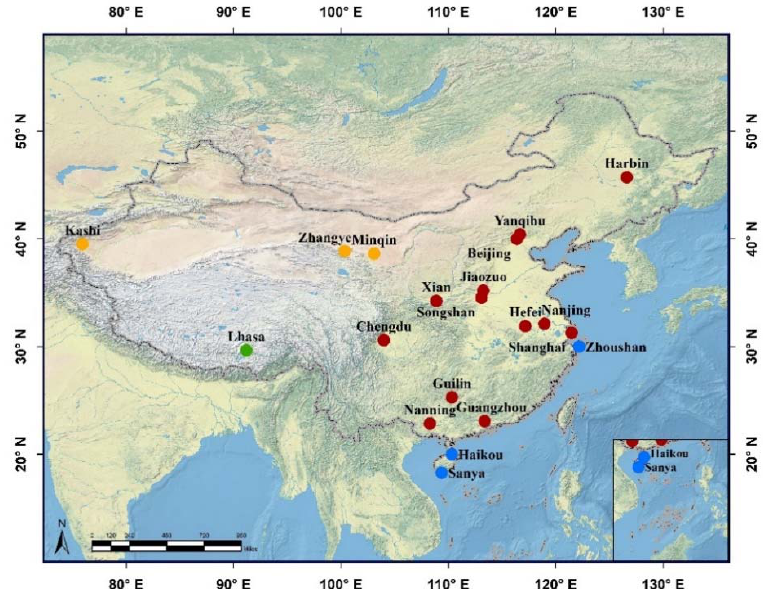
Figure 1. Geographical locations of the SONET long-term observation stations (orange dots: arid and semi-arid sites; green dot: continental background site; red dots: urban and suburban sites; blue dots: coastal sites).